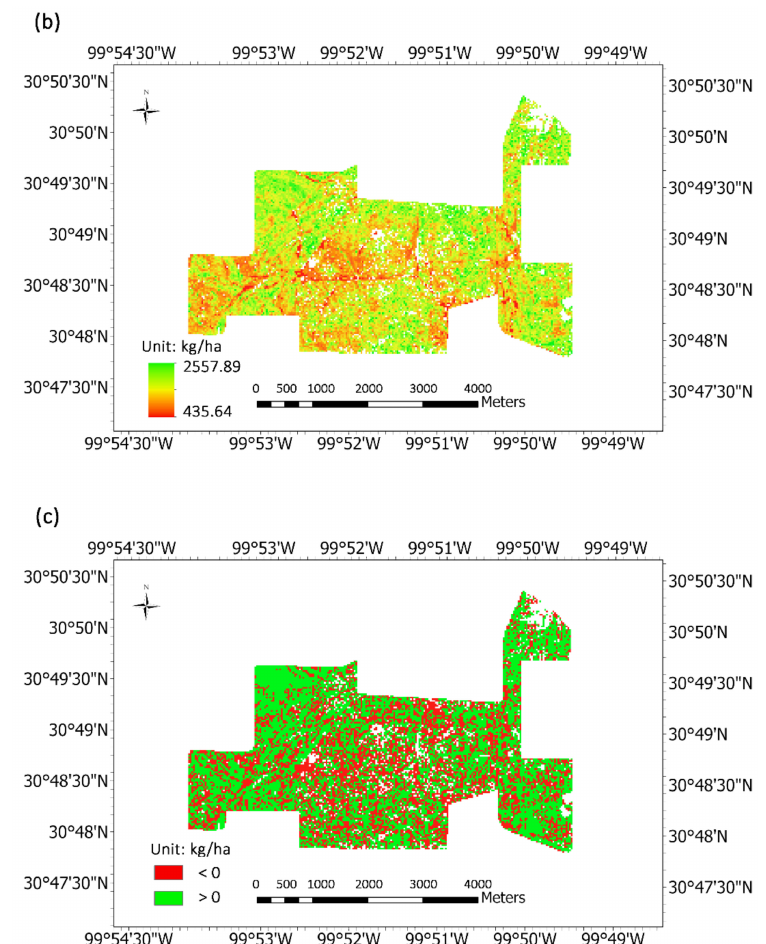
Figure 7. Biomass maps, estimated with the Random Forest algorithm and based on medium spatial resolution images and texture indices: ( a ) biomass map without fractional cover as explanatory variables, ( b ) biomass map with fractional cover as explanatory variables, and ( c ) differences in biomass between the maps with and without fractional cover as explanatory variables.